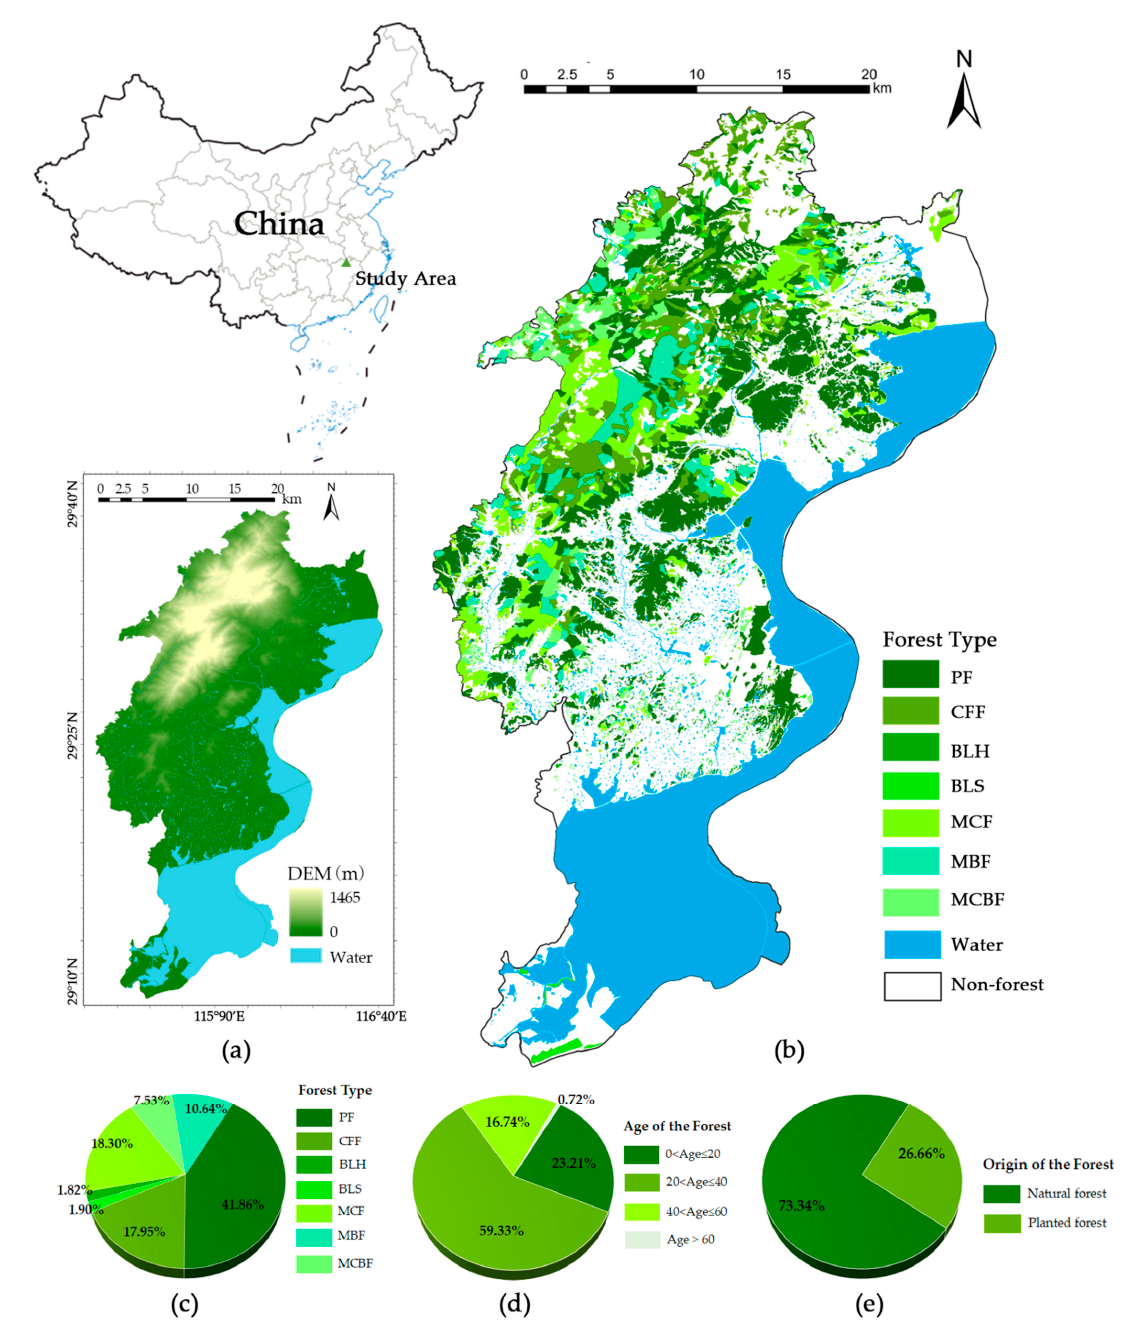
Figure 1. Location, topography, basic forest information, and forest patch distribution in the study area. ( a ) shows the location and topography of the area; ( b ) shows the distribution of different forest types. Based on the main dominant species of the forest fine patches in the forest management inventory, the forest patches were classified into 7 types: PF refers to pine forest composed of Pinus massoniana , Pinus taiwanensis , and Pinus elliottii ; CFF refers to Chinese fir forest composed of Cunninghamia lanceolata and Cryptomeria japonica ; BLH refers to hard broad forest composed of Cinnamomum camphora , Quercus L. and other hard broad species; BLS refers to soft broad forest composed of Populus L., Paulownia fortunei and other soft broad species; and three types of mixed forests: mixed coniferous forest (MCF), mixed broadleaf forests (MBF) and mixed conifer-broadleaf forests (MCBF); ( c ) shows the area share of different forest patches; ( d ) shows average age composition of forest patches; ( e ) shows the origin of the forest patches (natural forest/planted